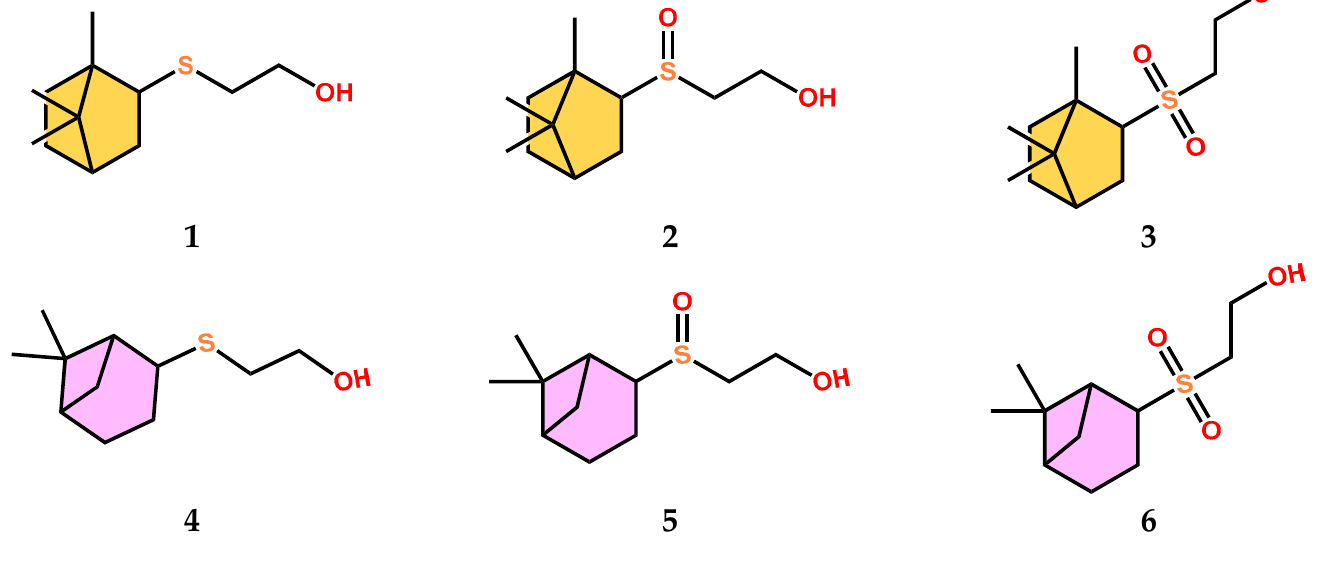
Figure 1. Structures of compounds 1–6 . Synthesis, physicochemical properties, and spectral data of compounds 1–6 were described in detail in our previous papers